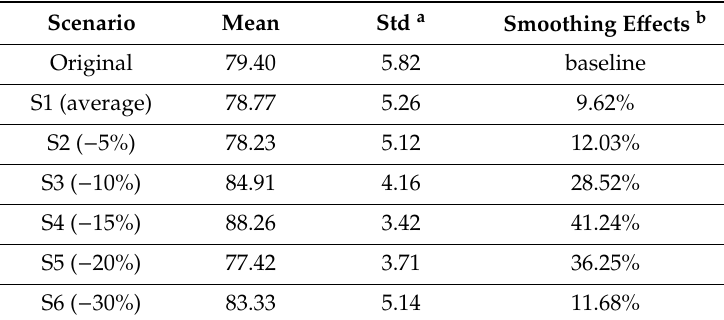
Table 2. The ED occupancy between di ff erent scenarios.